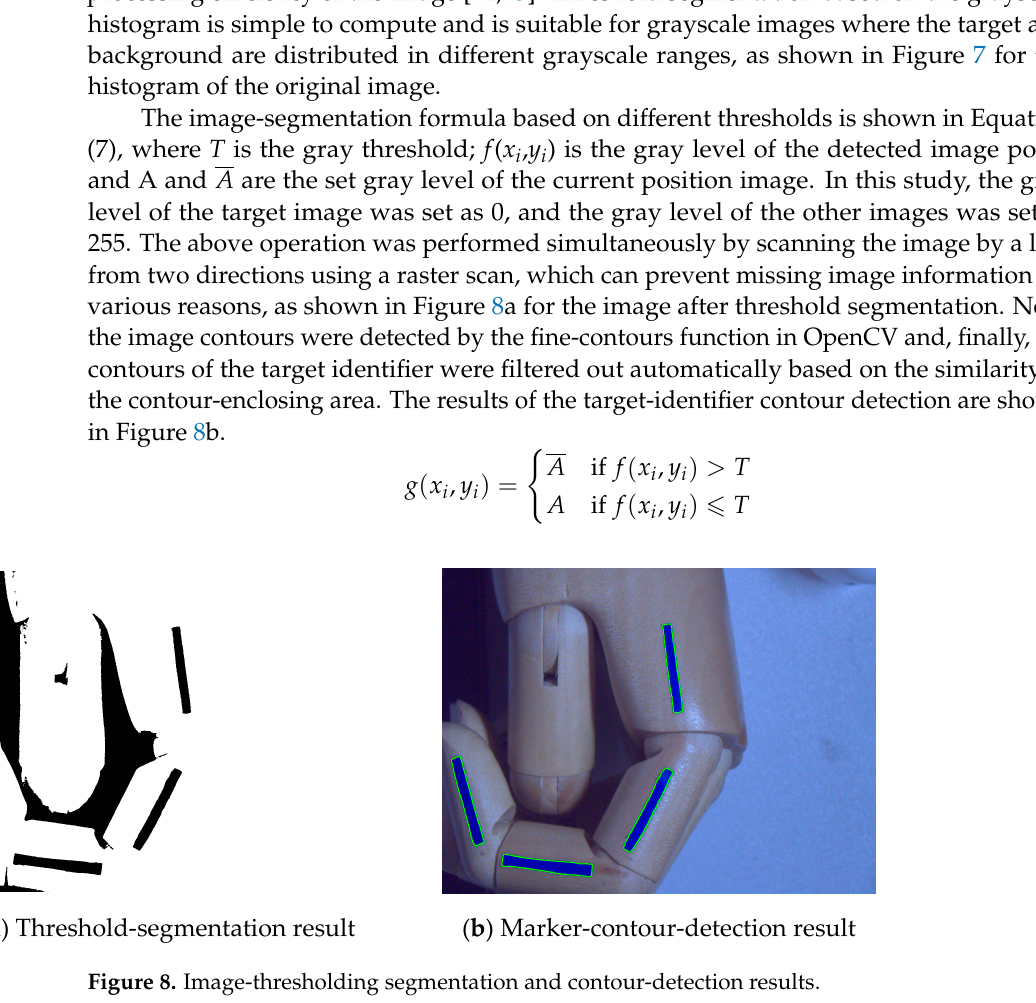
Figure 7. HSV marker segmentation and edge detection.